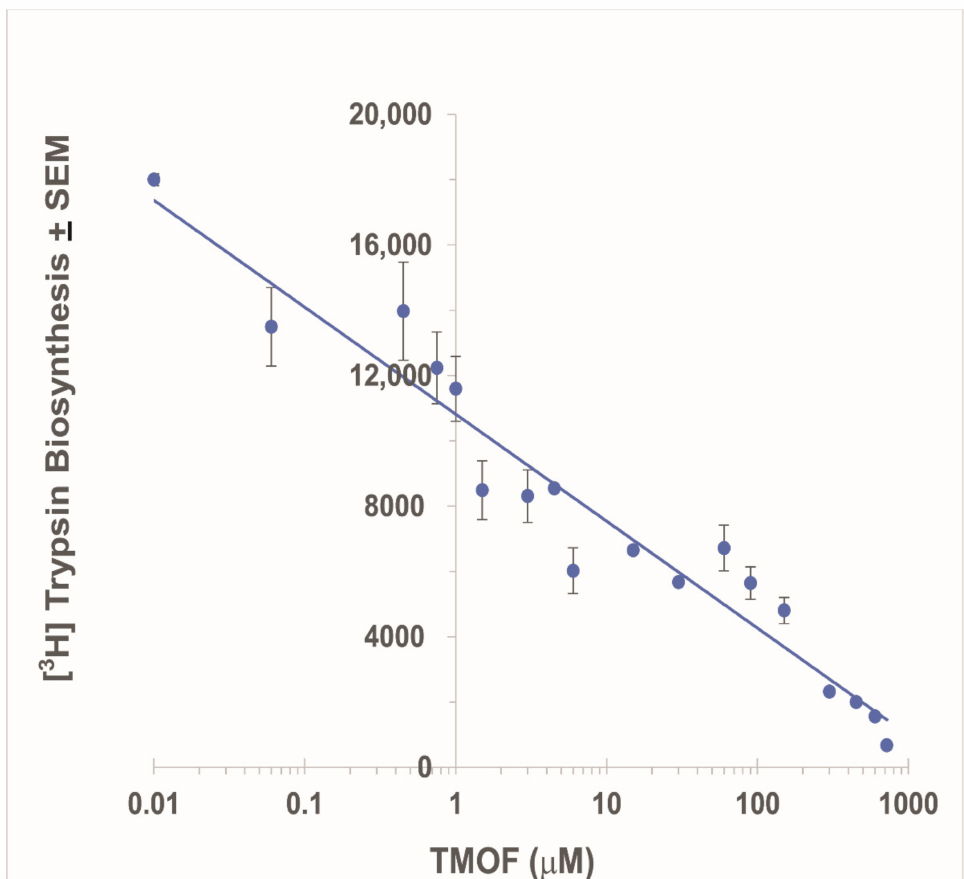
Figure 2. Inhibition of Ae. aegypti late larval [ 3 H]trypsin biosynthesis by increasing concentrations (0.01–750 µ M) of Aea TMOF in the S. frugiperda TnT T7 insect cell extract protein expression system, showing an IC 50 of 1.8 µ M. Each point is a mean of three determinations ± SEM (see Section 2.4 for